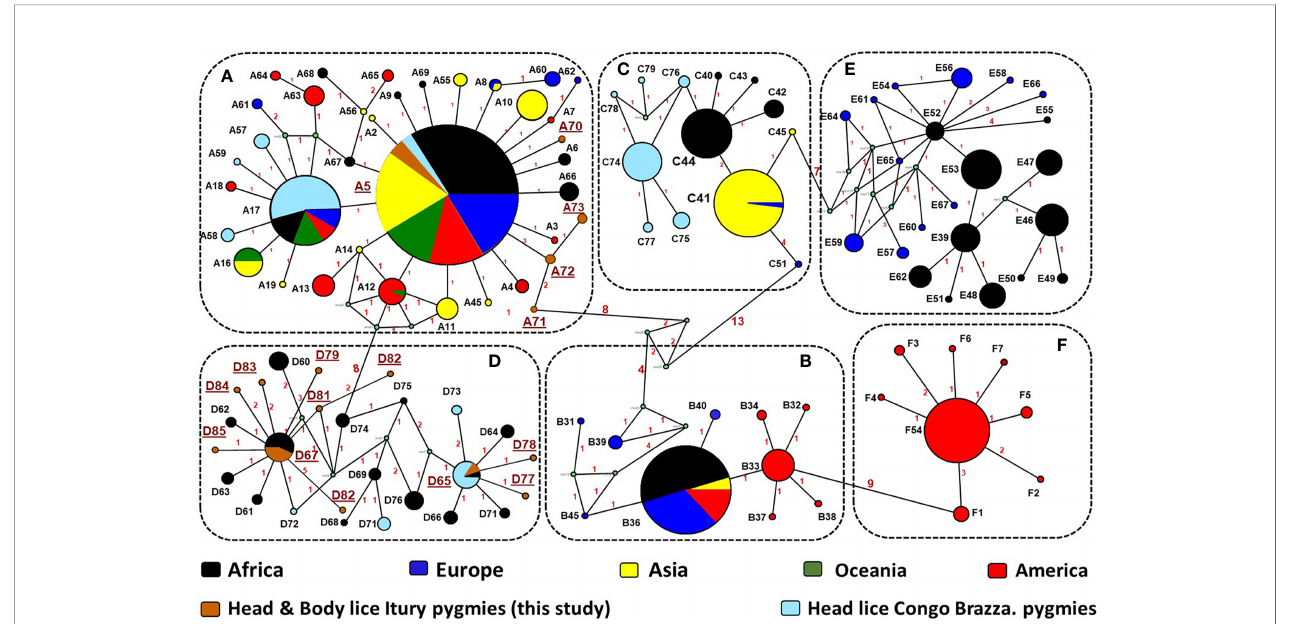
FIGURE 4 | Cytb haplotype networks of Pediculus body and head lice. Each circle indicates a unique haplotype (272 bp) and variations in circle size are proportional to haplotype frequencies. Pie colours and sizes in circles represent the continents and the number of their sequence for a haplotype. The length of the links between nodes is proportional to the number of mutations. The types of haplotypes identi fi ed in this study are underlined.